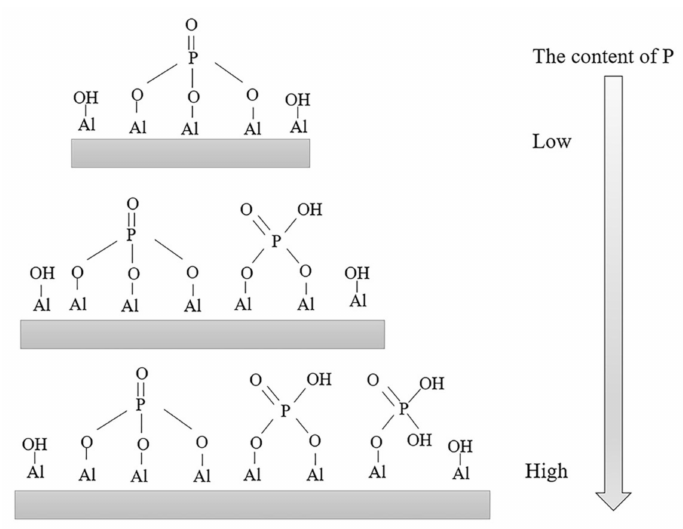
Figure 5. Profile of the relationship between phosphate compounds and phosphorus content on the surface of xP θ -Al 2 O 3